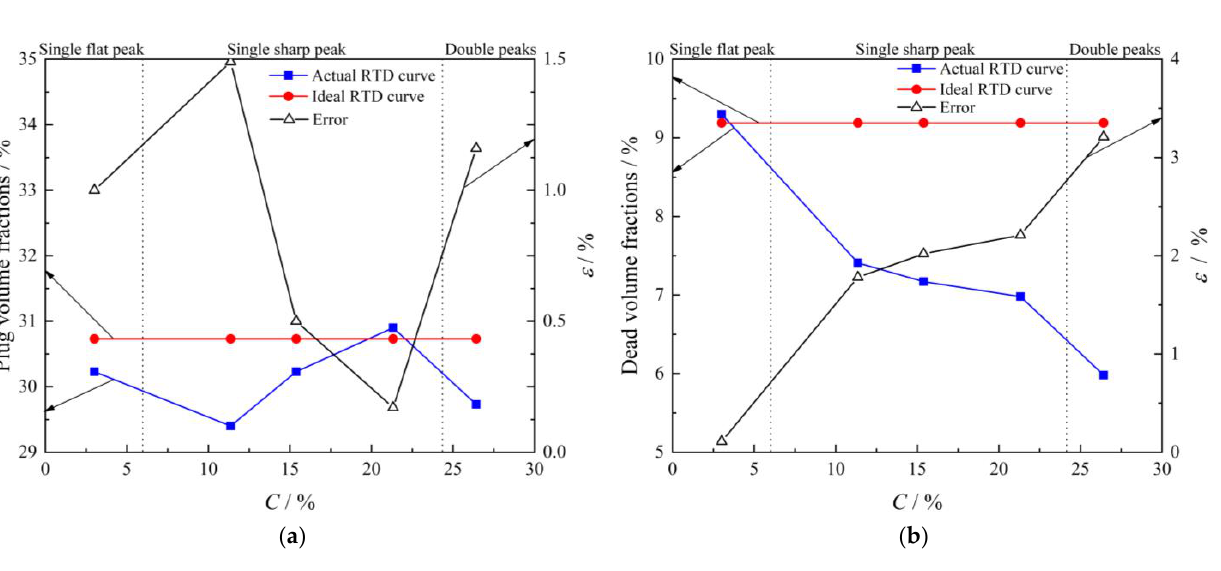
Figure 7. RTD curves for the different tracer mass concentrations.